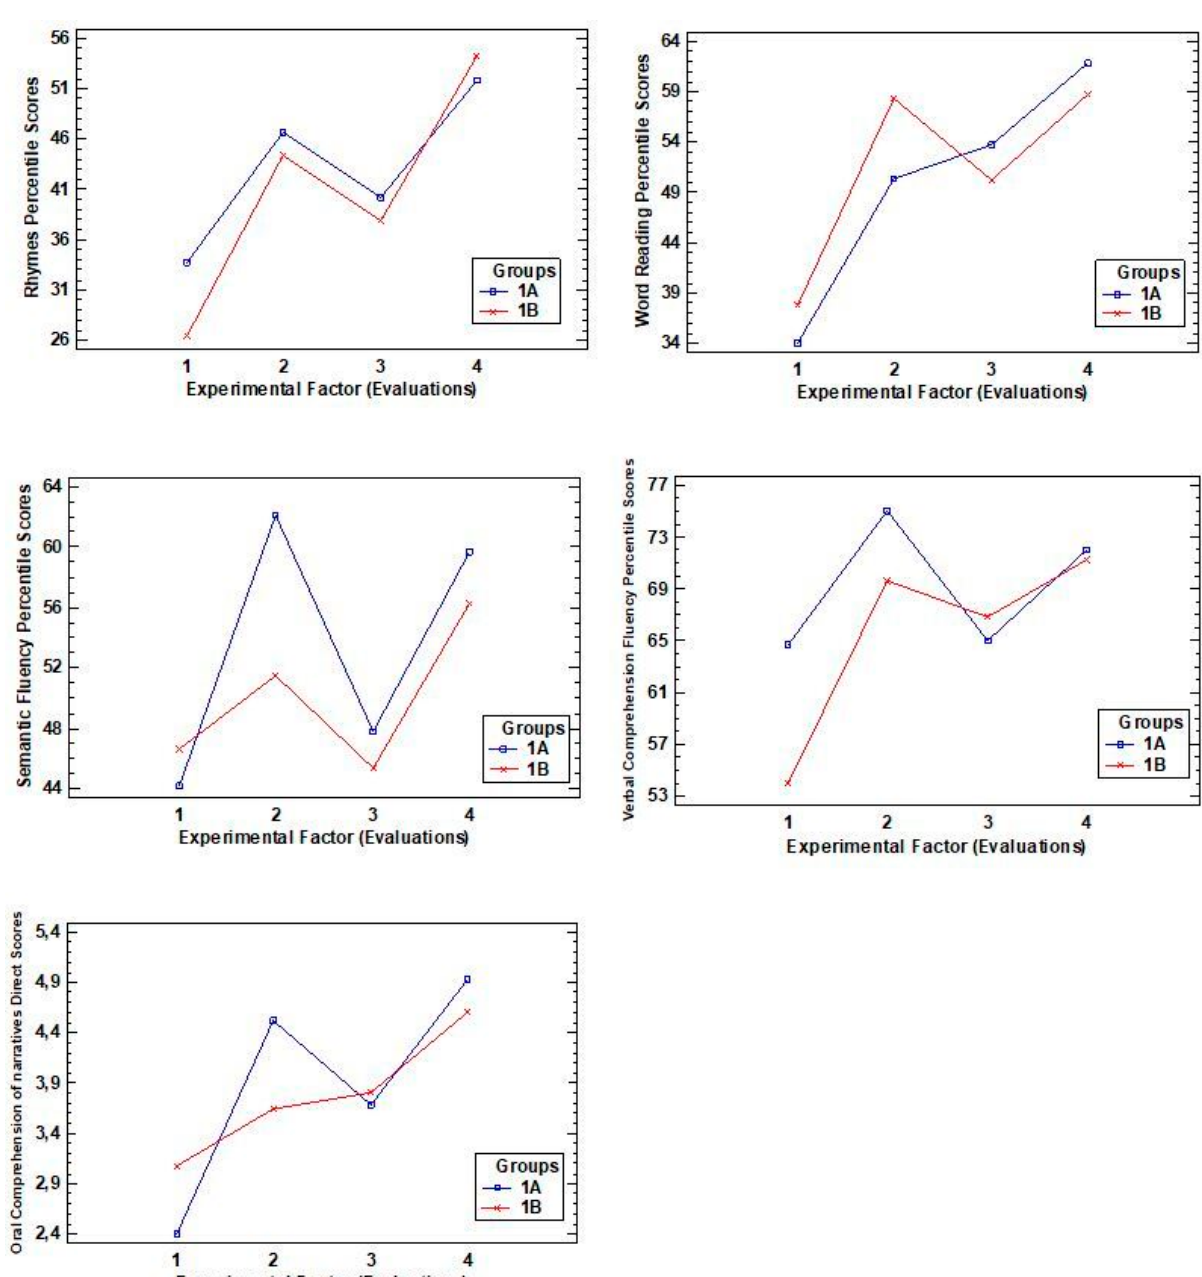
Figure 1. Graphs showing the interaction of the variables: rhymes (phonological awareness), word reading (decoding), semantic fluency and verbal comprehension (vocabulary), oral narrative com- prehension.